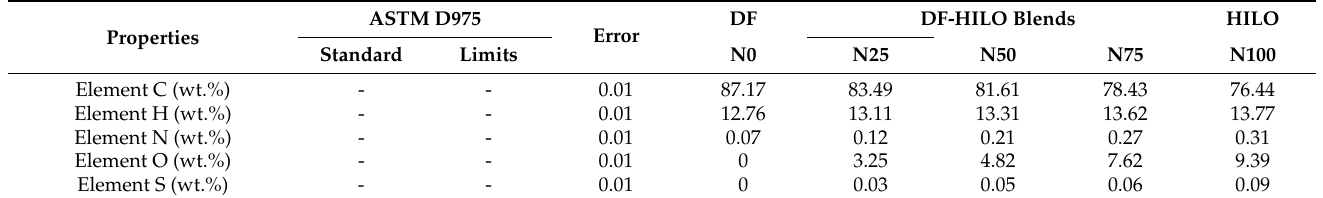
Figure 4. The GC chromatogram of HILO. The chemical compositions of the diesel fuel and HILO were determined from the peak of chromatograms. The mass spectrum data identified them as tabulated in Table A1 (Appendix A) and Table A2 (Appendix B), respectively. Table 3 summarized the chemical composition of diesel fuel and HILO determined in this study. Based on the mass spectrometer findings, diesel fuel was composed of various hydrocarbons with varying chain lengths. The primary chemical composition in the diesel fuel is made up of 73.3095 wt.% paraffin (alkane) of volatile compounds. Aromatics comprised 22.085 wt.% of the volatiles, while carboxylic acids accounted for 2.9747 wt.%. An olefin series total for 1.6309 wt.%. The high content of the alkane hydrocarbon family in the diesel fuel is remarkable compared to the remaining family of the hydrocarbon compound. On the other hand, HILO was composed of almost different chemical compositions than diesel fuel. HILO predominantly consisted of 95.113 wt.% carboxylic acids (fatty acids) of vola- tiles compounds. Ketones content was 0.0771 wt.% and other compounds accounted for